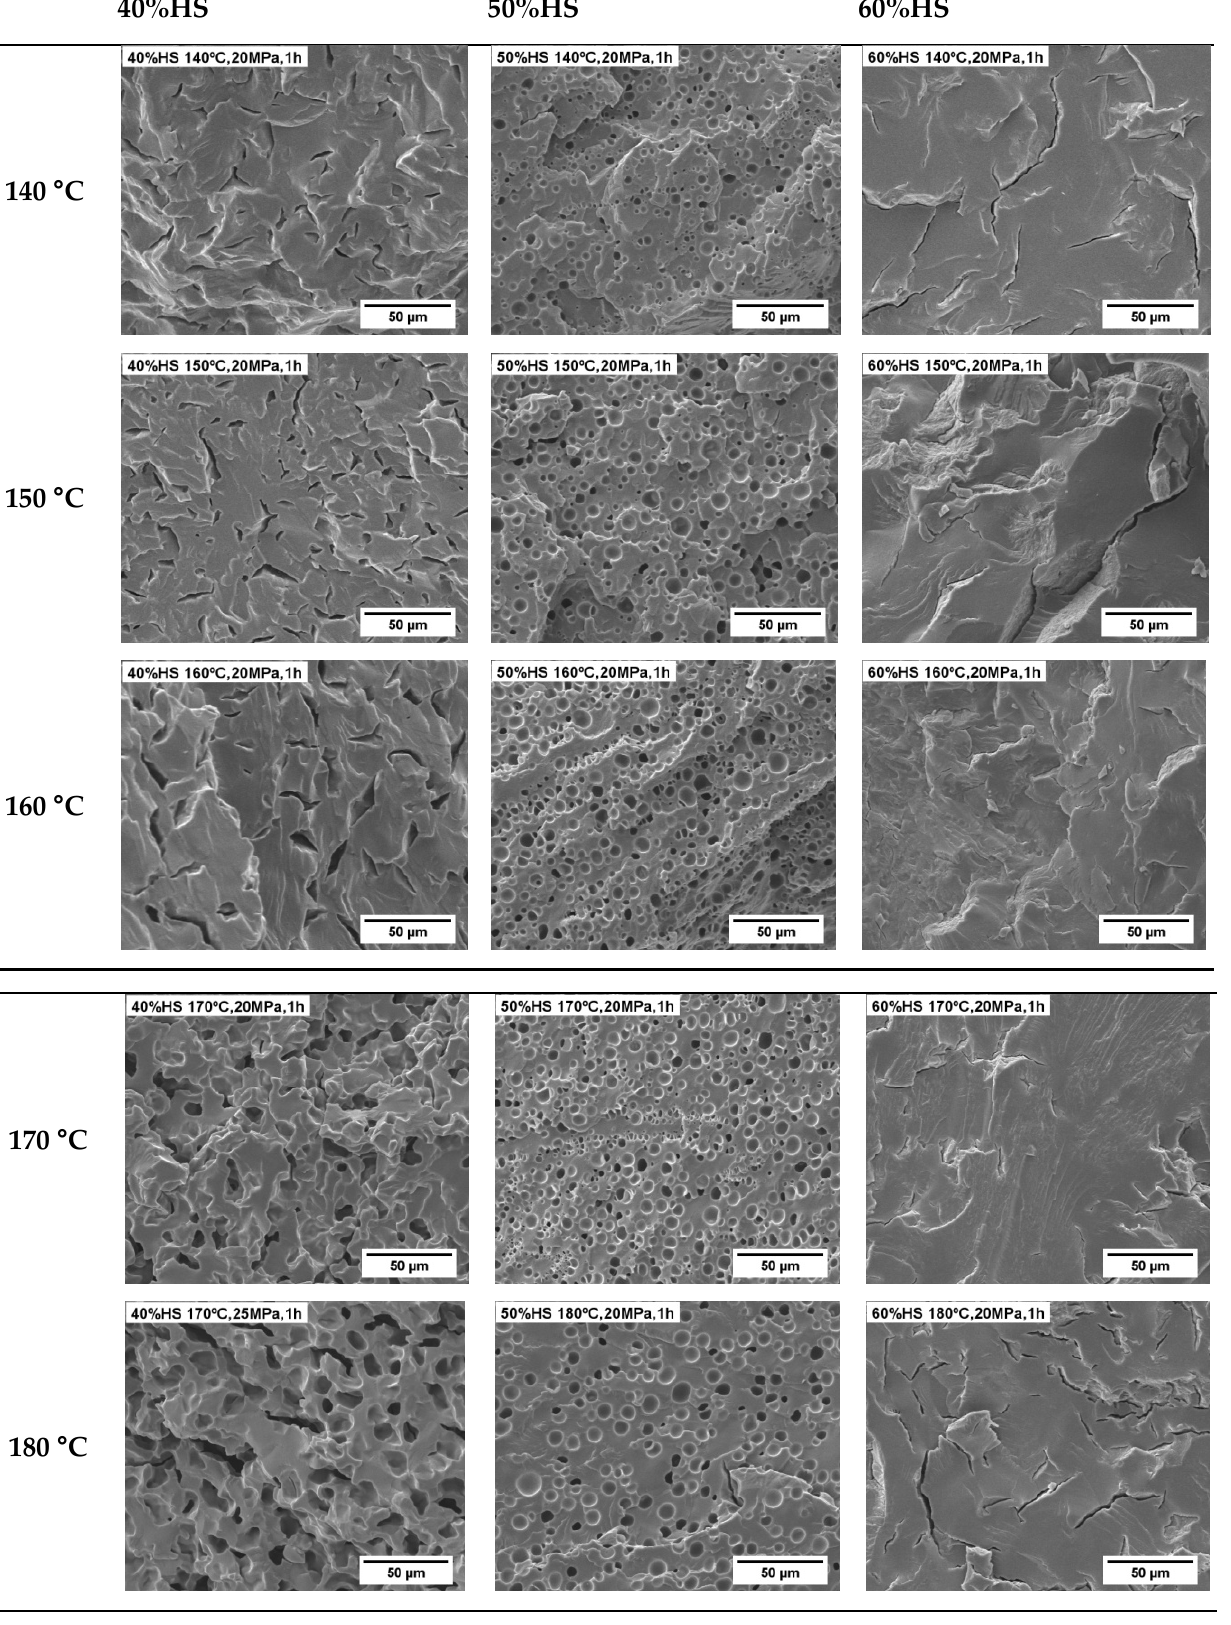
Figure 6. Relative density ( A ), cell size ( B ), and cell nucleation density ( C ) of TPU 50%HS foamed by one-step between 140 and 180 ° C, 20 MPa, and 1 h. Since the TPU 50%HS is the optimum content of HS, it was selected in order to op- timize the foaming of our TPU system in the second part of this study. For this purpose, the influence of the saturation pressure for TPU 50%HS was evaluated using four dif- ferent saturation pressures: 10, 15, 20, and 25 MPa, whereas the foaming temperature and foaming time were kept constant at 170 °C and 1 h, respectively. The SEM micrographs and parameters of the TPU foams with 50 wt.% HS are collected in Figures 7 and 8. Fig- ure 8A shows the relative density values, which decrease with the saturation pressure,